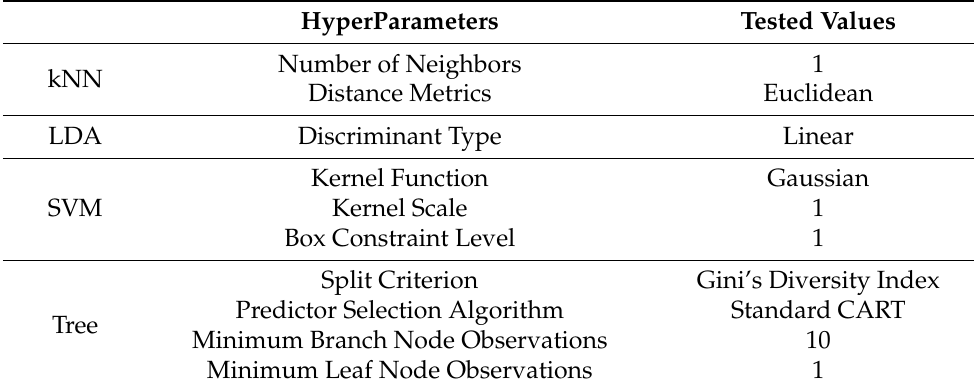
Table 1. Hyperparameters of the implemented models.